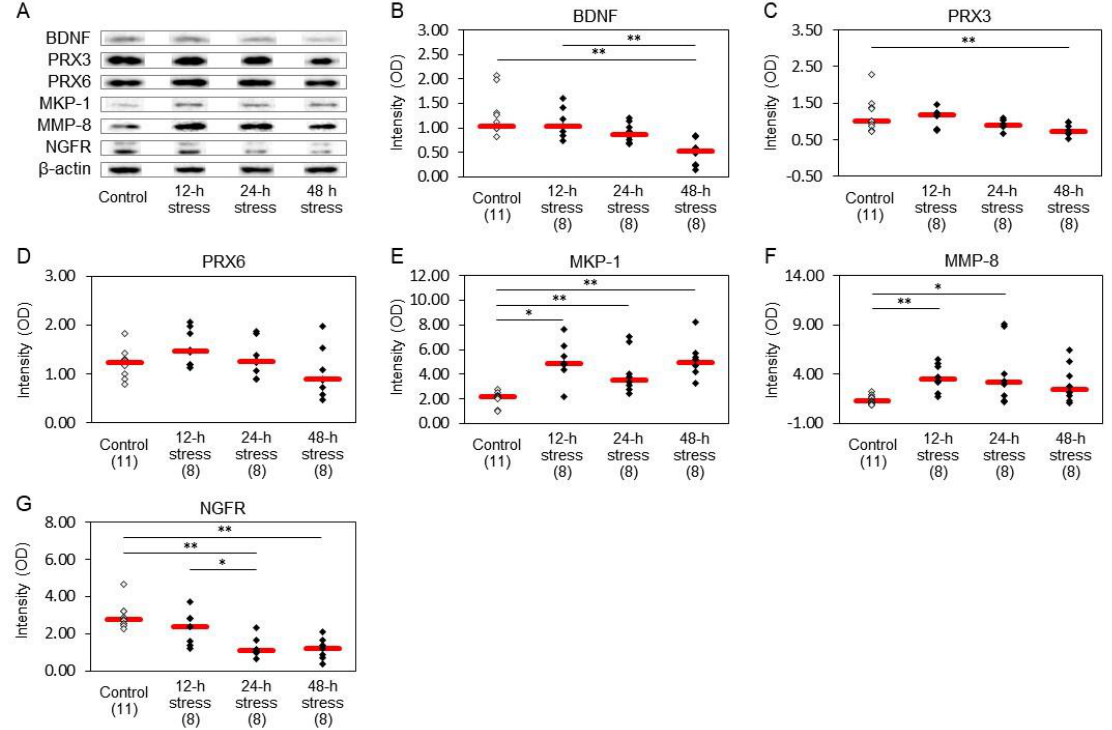
Figure 4. Protein expression profiles in the rat hippocampus. After exposure to stress, the hippo- ern blotting. The intensities of optical densities are expressed relative to beta-actin expression in each sample. ( A ) Representative blots of BDNF, PRX3, PRX6, MKP-1, MMP-8, NGFR, and